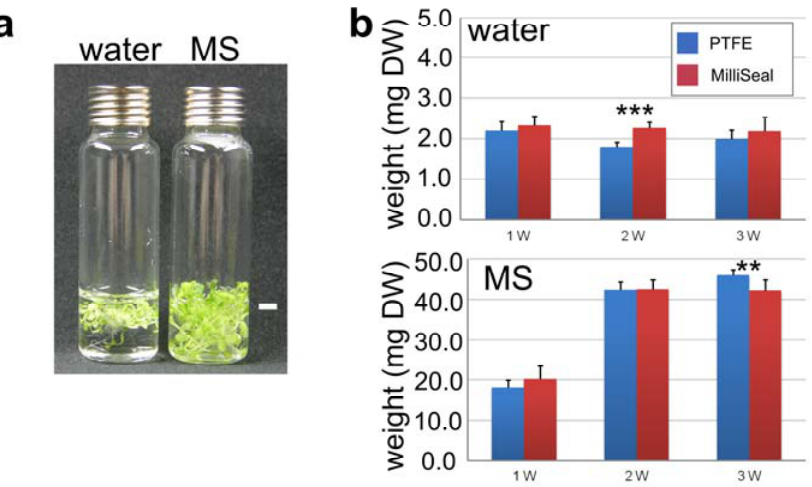
Figure 2. Biomass of Arabidopsis seedlings grown under the developed cultivation system. (a) Visual phenotypes of Arabidopsis seedlings grown in sterilized Milli-Q water (left) or sterile liquid culture in Murashige and Skoog (MS) medium and 1% sucrose (right) after seven-day cultivation. Twenty seedlings were put in an HS vial. Scale bar,